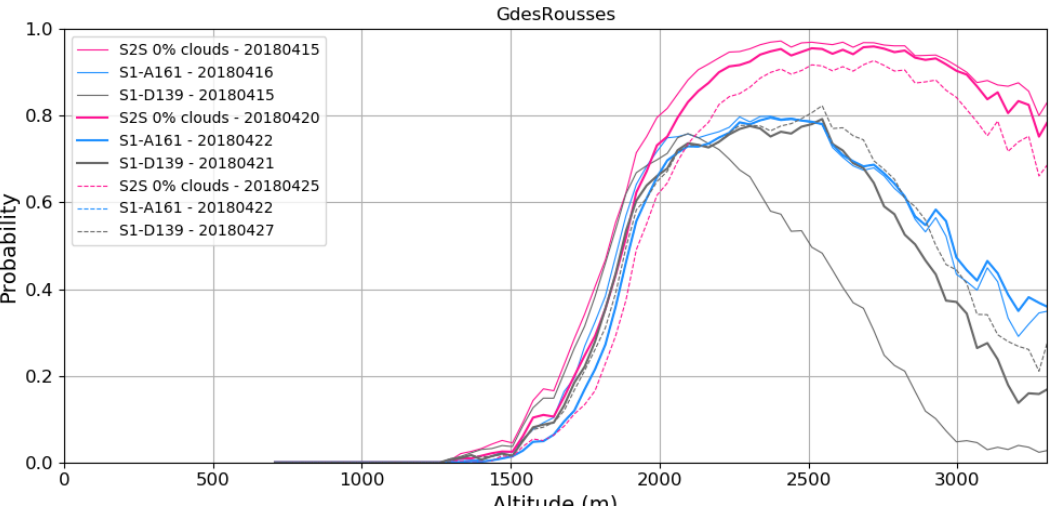
Figure 5. Probability curves describing the occurrence of snow by altitudes at the scale of the Grandes Rousses massif obtained for three successive Sentinel-2 dates (pink curves): 15 April 2018, 20 April 2018 and 25 April 2018, for which no cloud was recorded over the Grandes-Rousses massif. The figure also shows the obtained snow probability curves from SWS products for Sentinel-1 ascending scenes observed on 16 April 2018 and 22 April 2018 (blue curves) and for Sentinel-1 descending scenes observed on 15 April 2018, 21 April 2018 and 27 April 2018 (Gray